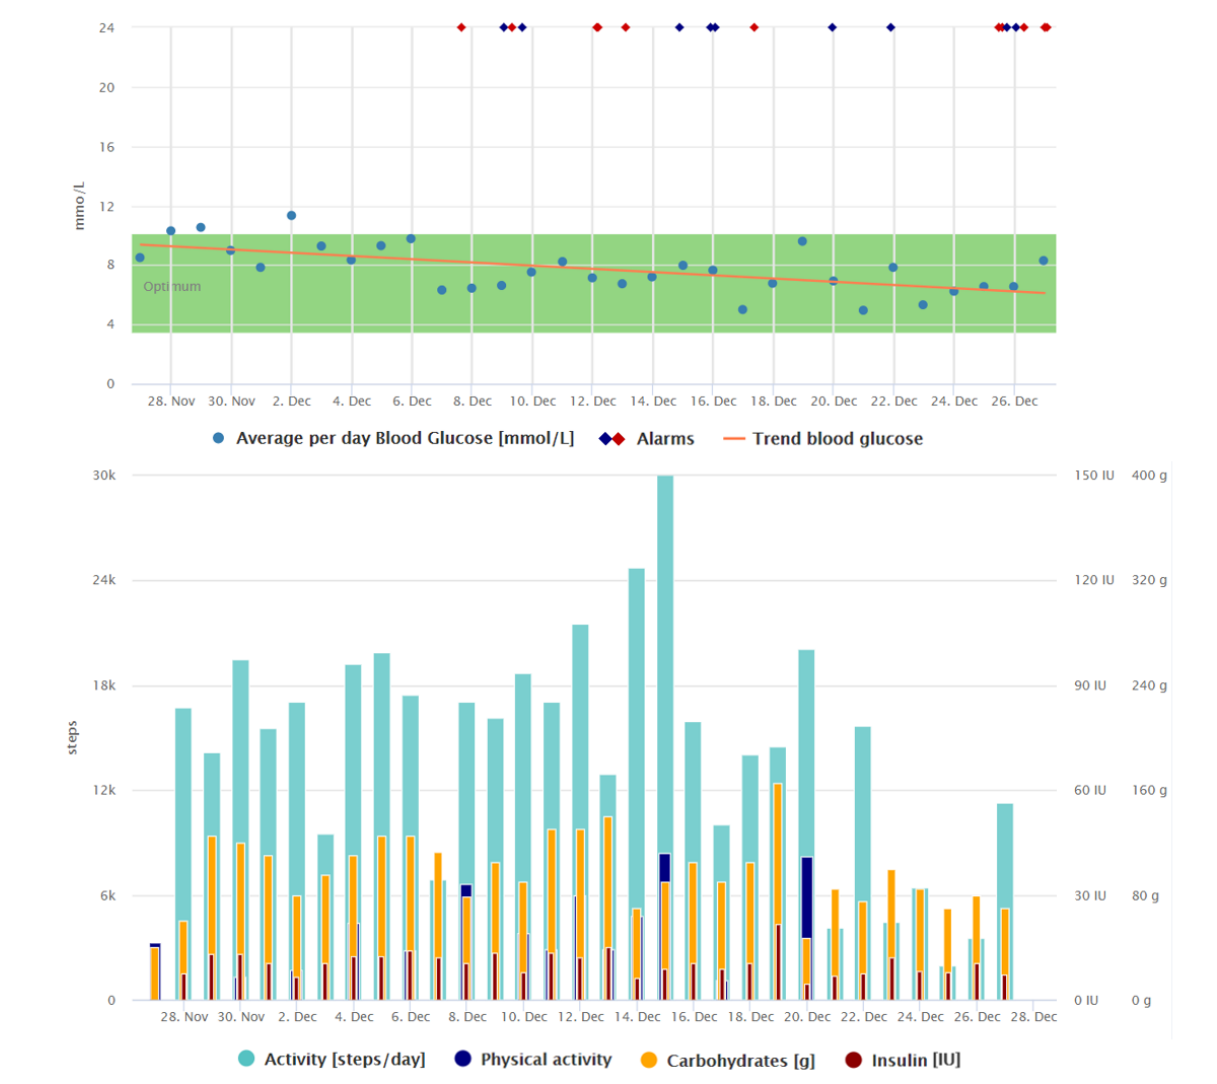
Figure 2. Graphical interpretation of 1-month data registrations of the patient from the case study 2, visualized by the Diani Web app. In the